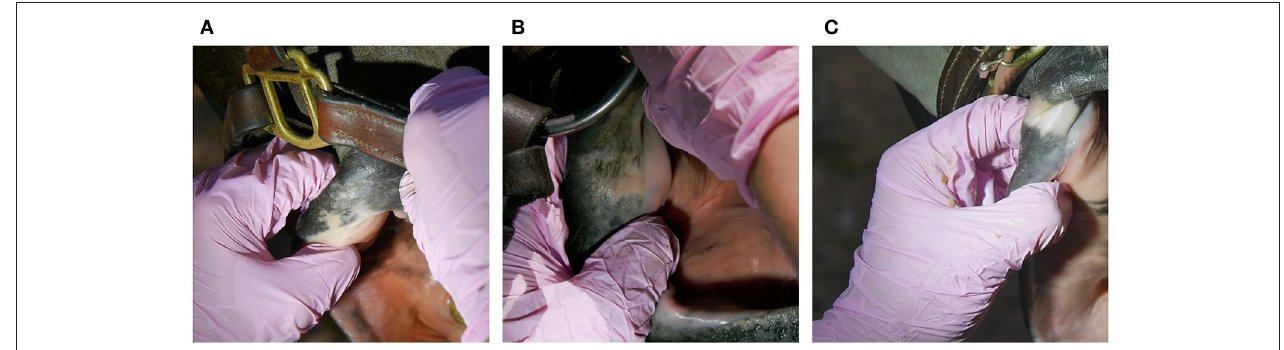
FIGURE 4 | Various degrees of pigment loss on outer lip commissures (A–C) . Prolonged bit pressure or previous inflammation may inhibit melanocyte function and cause depigmentation on areas that should normally be pigmented (22,